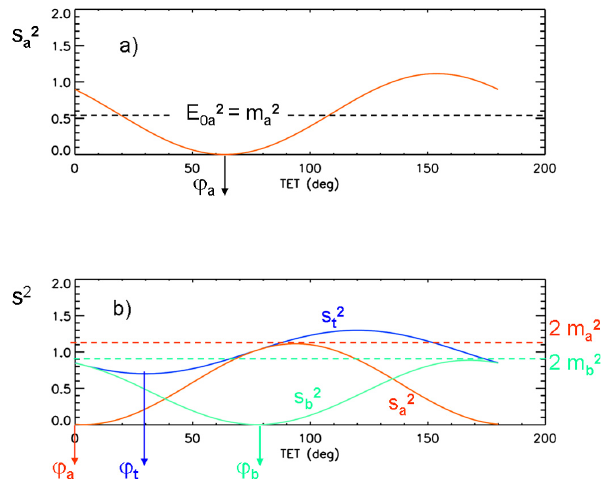
Fig. A1. Variation of measured signal (electric field power density) as a function of antenna attitude θ in case of (a) linear polarization; and (b) elliptic polarization, where the measured signal s 2 t is the sum of two linear components s 2 a and s 2 , projected in spin b